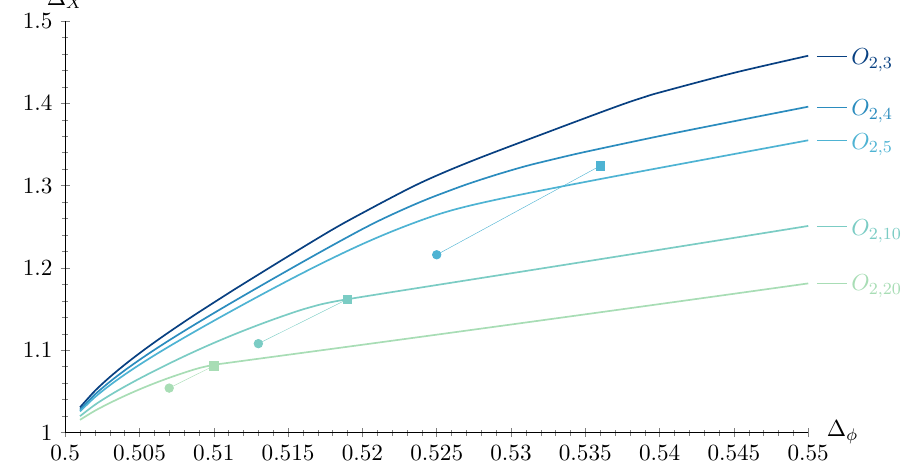
× φ Figure 2: Upper bound on the dimension of the first scalar X operator in the φ ar bs OPE as a function of the dimension of φ . Areas above the curves are excluded in the corresponding theories. The positions of the fixed points as predicted by the large- n results (8), (9) for ∆ φ and (73), (74) for ∆ for n = 5,10,20 are also given as squares X and circles for the chiral and antichiral fixed points, respectively. (The lines between squares and circles are added to illustrate fixed points with the same